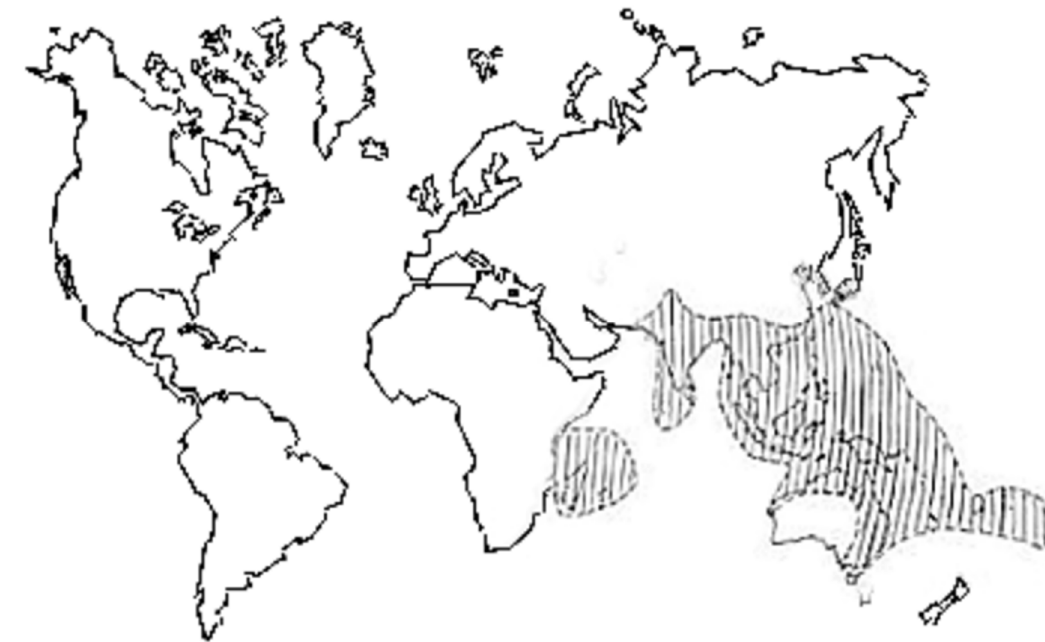
Figure 2. World distribution of fruit bats [30].